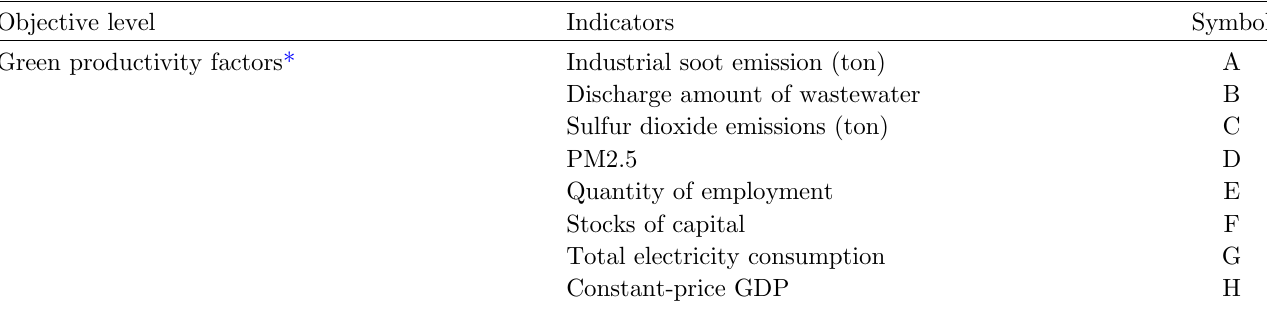
Table 3. Indicators of in fl uencing factors of spatial